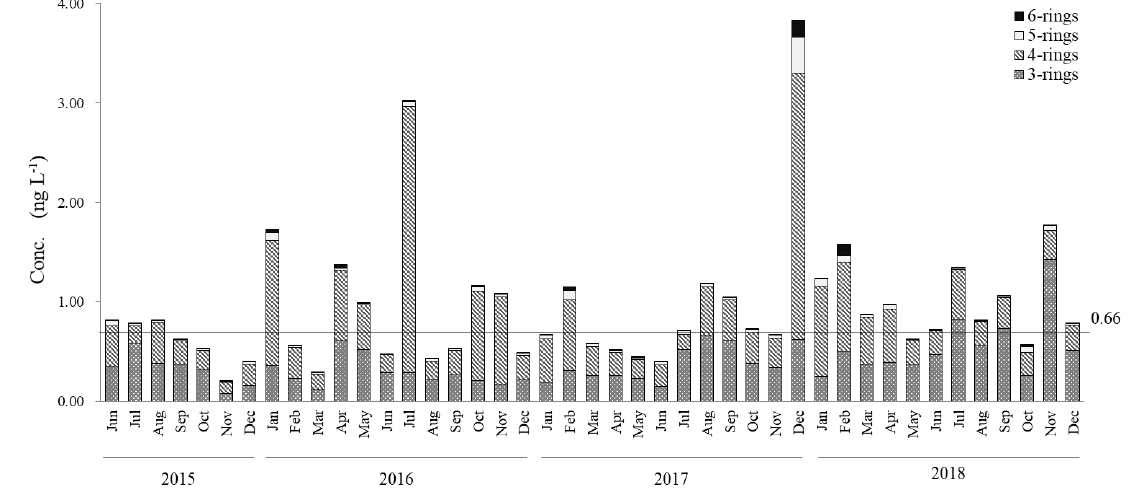
Figure2. Monthlyvariationsinconcentrationsofthree-ringtosix-ringpolycyclicaromatichydrocarbons Figure 2. Monthly variations in concentrations of three-ring to six-ring polycyclic aromatic (PAHs) in the dissolved phase in surface seawater in North Nanao Bay during hydrocarbons (PAHs) in the dissolved phase in surface seawater in North Nanao Bay during 2015– 2018.